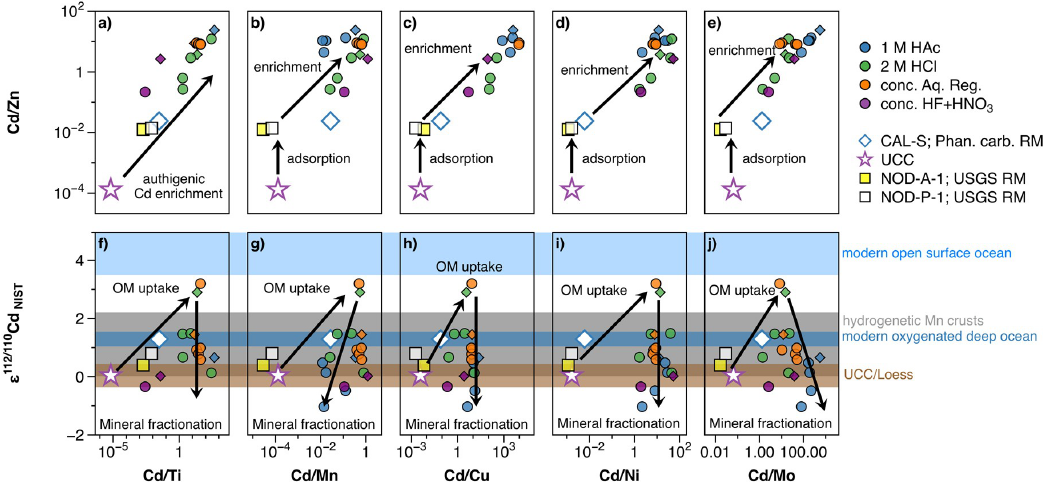
Figure 4. ( a – e ) Cd / Zn ratios relative to Cd over Ti, Cu, Ni, Mn, and Mo of leachate steps L1 to L5. ( f – j ) stable Cd isotope compositions relative to Cd over Ti, Cu, Ni, Mn, and Mo of leachate steps L1 to L5. Diamonds represent the respective compositions obtained in the analysed shale lithology. Loess data [56], surface ocean [79–81], deep ocean [54], and hydro genetic Mn crusts [82]. Long-term reproducibility of spiked Cd isotope reference material NIST SRM 3108 is 0. 4 ε units